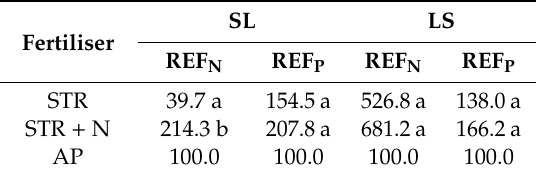
Table 3. Related fertiliser e ffi ciency (REF) (%) of STR and STR + N.